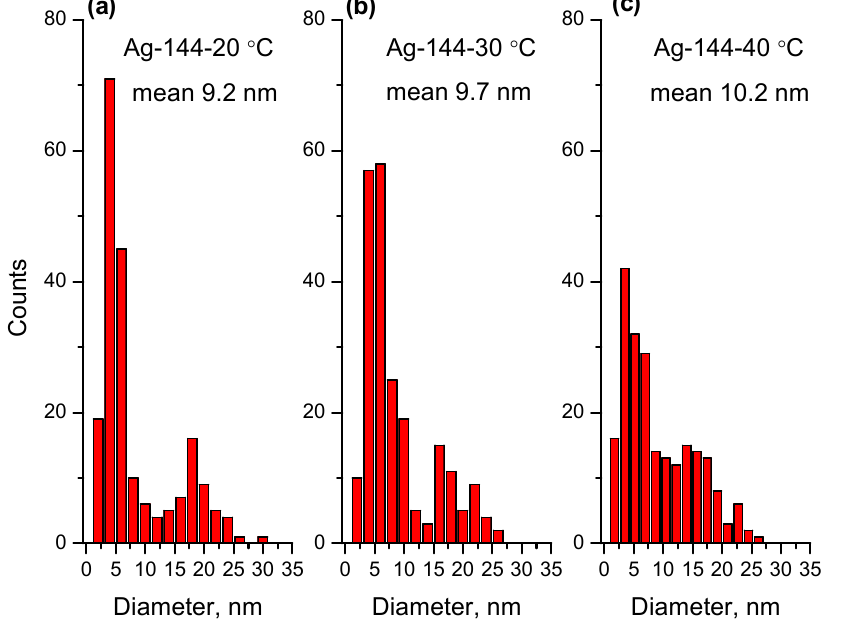
Figure 6. Size distribution for the samples ( a ) Ag-144-20 ° C, ( b ) Ag-144-30 ° C and ( c ) Ag-144-40 ° C.